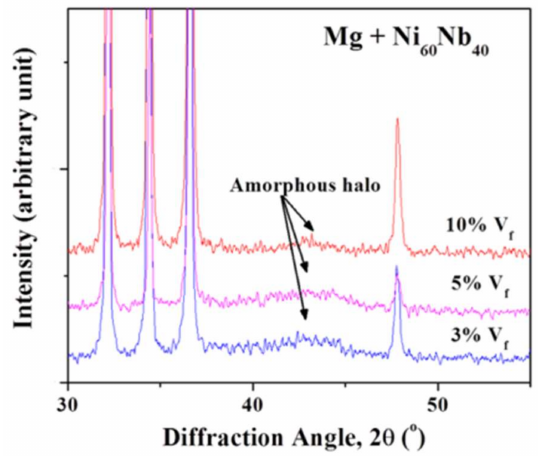
Figure 13. X-ray diffraction pattern showing retention of the amorphous phase in pure magnesium reinforced with Ni 60 Nb 40 (atomic pct.) amorphous alloy powder, synthesized by bi-directional microwave sintering [35]. (© 2014, Elsevier. Used with permission).